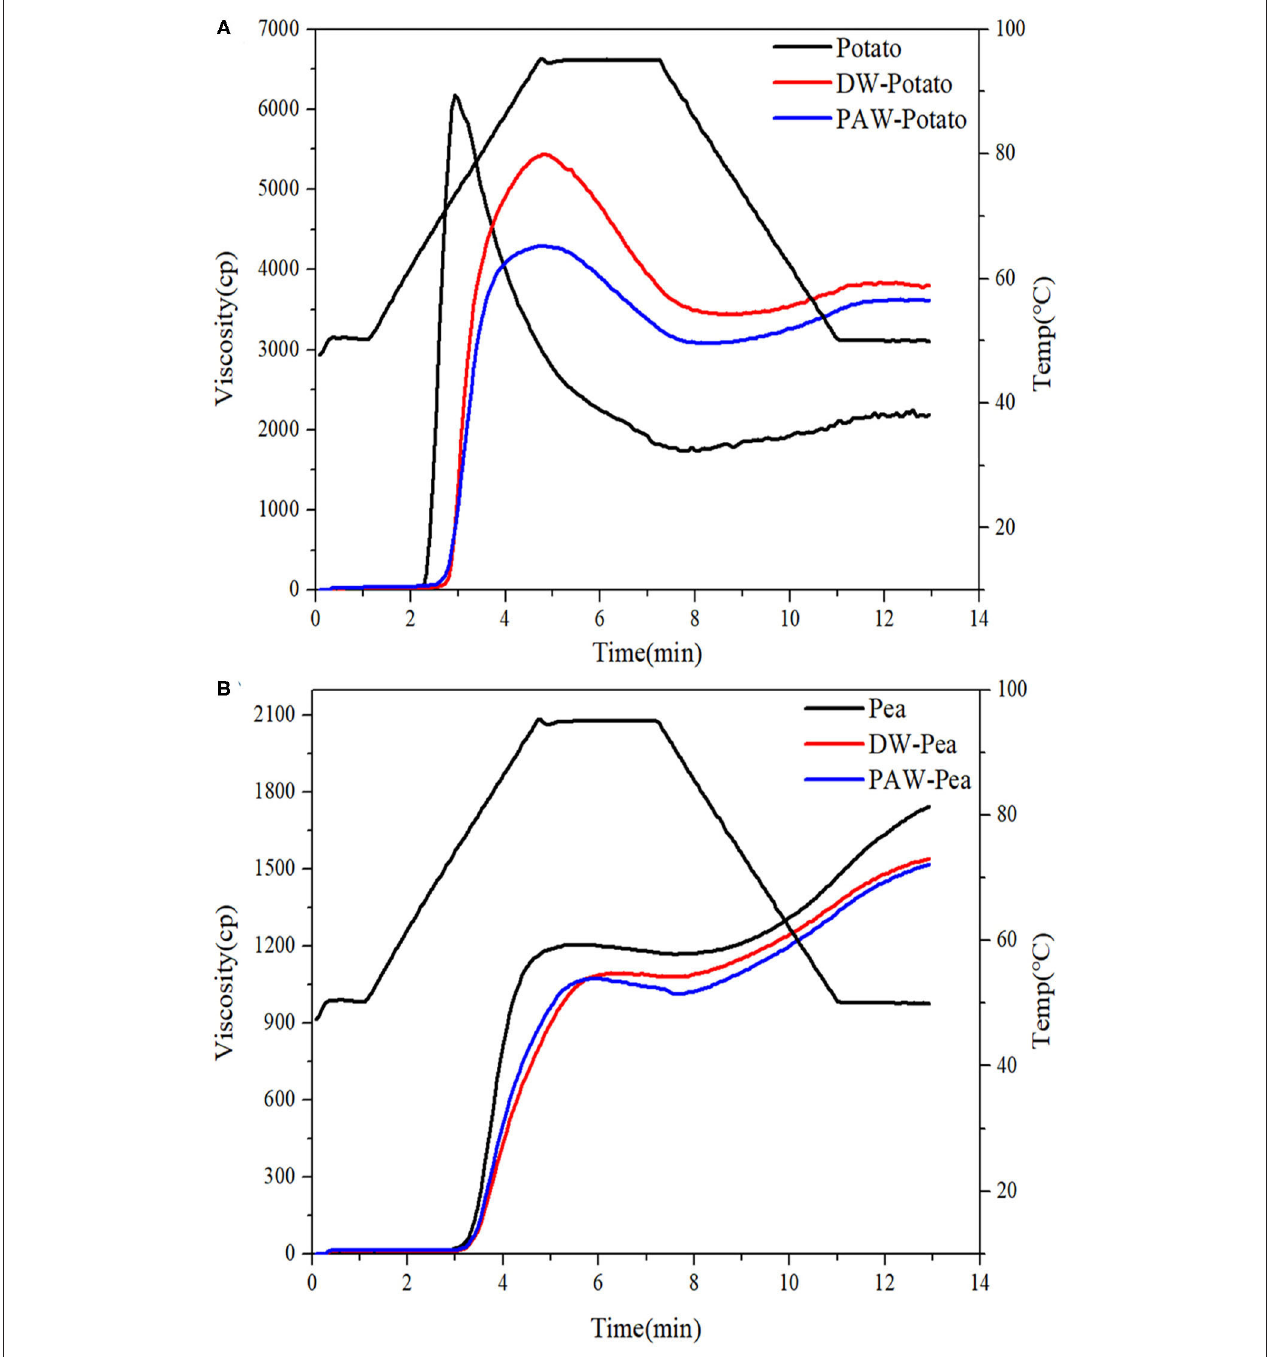
FIGURE 6 | Pasting curves of native and modified starches. (A) Native, DW-ANN treated, and PAW-ANN treated potato starch. (B) Native, DW-ANN treated, and PAW-ANN treated pea